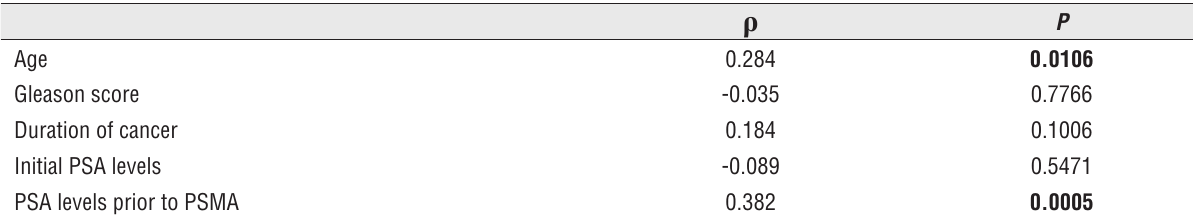
Table 2 - correlation of the highest SUvmax values in patients that underwent 68 Ga-pSMA pET/cT with the variables age, Gleason score, Duration of cancer, Initial pSA levels and pSA levels immediately prior to pSMA.